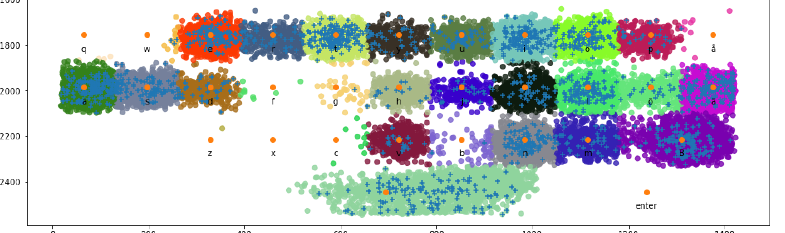
Figure 5. Keyboard touches and gazes for a single user, after transformation of gaze coordinates. Touchpoints are colorised according to the corresponding key they were mapped to, while gaze data is show in blue crosses.